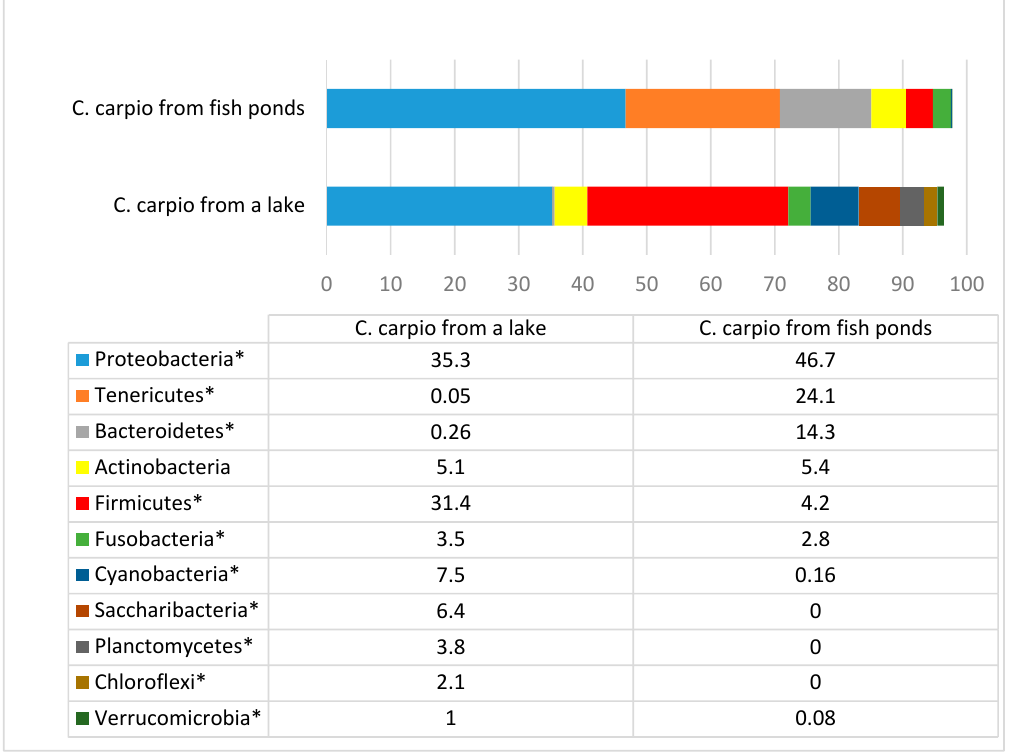
Figure 1. Bacterial phyla prevalence (%) in Cyprinus carpio gut. * statistically significant results ( p ≤ 0.05) between the number of bacteria of separate phyla.